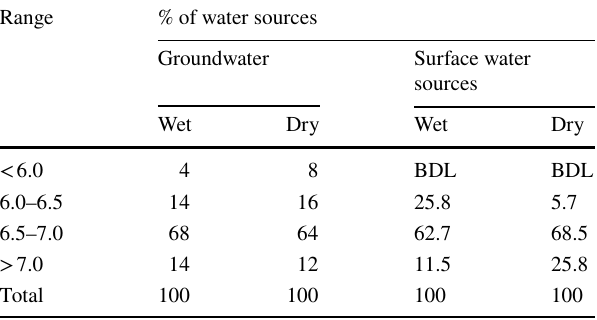
Table 4 Classification of water sources based on TDS (mg/L)